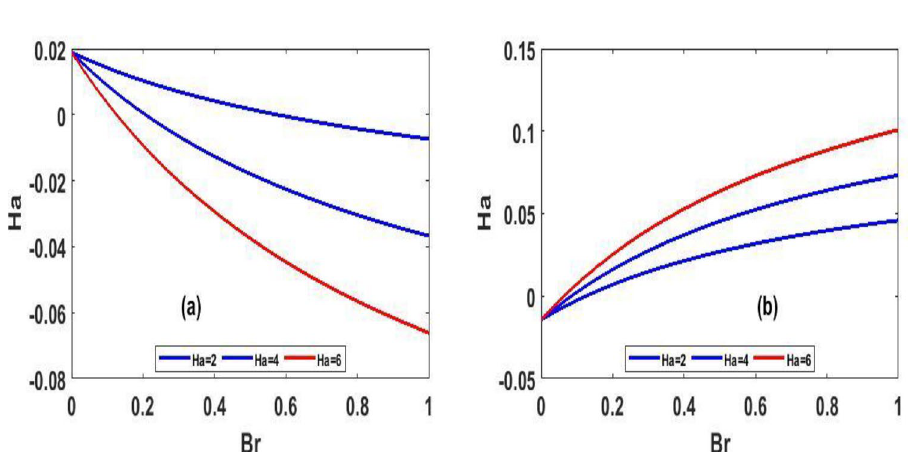
Figure 9. Steady state skin friction for ( Ha ) against ( Br )